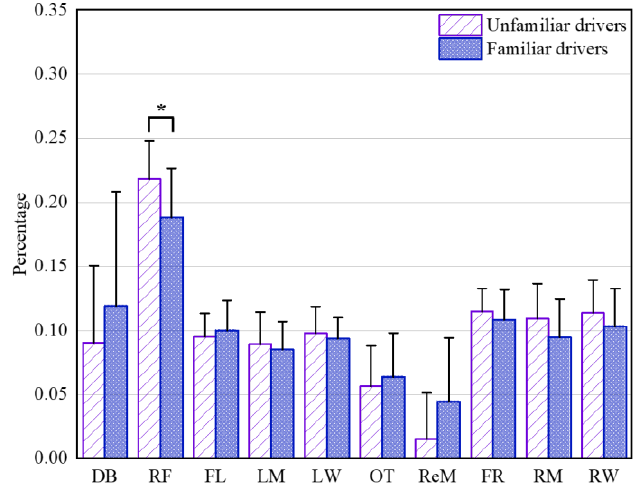
Figure 6. Percentages of average duration of fixations at each AOI at urban intersections for unfamiliar drivers and familiar drivers. * denotes significance at the 0.05 level ( p ≤ 0.05). RF refers to right front, FL refers to front-left, FR refers to front-right, LW refers to left window, LM refers to left mirror, RW refers to right window, RM refers to right mirror, ReM refers to rearview mirror, DB refers to dashboard and OT refers to others.